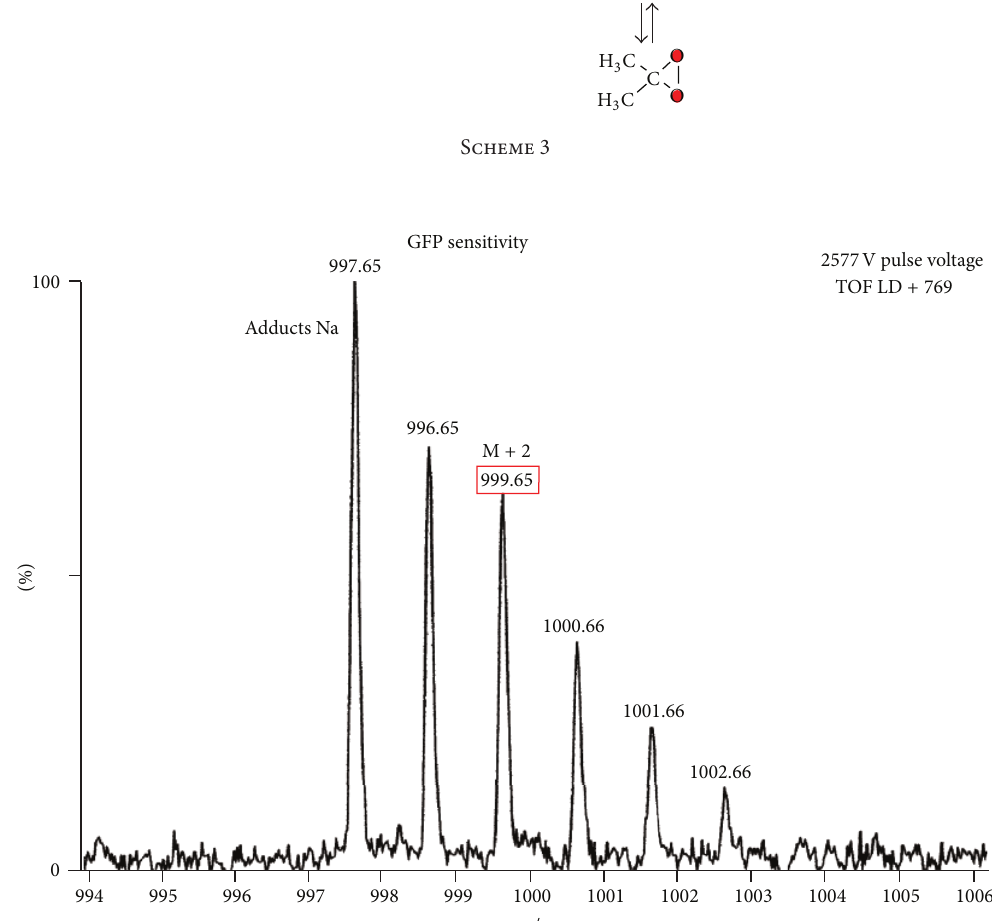
Figure 3: MALDI-TOF spectrum of of exa-epoxy-three linoleate glyceryl- 18 O labelled ( 2a